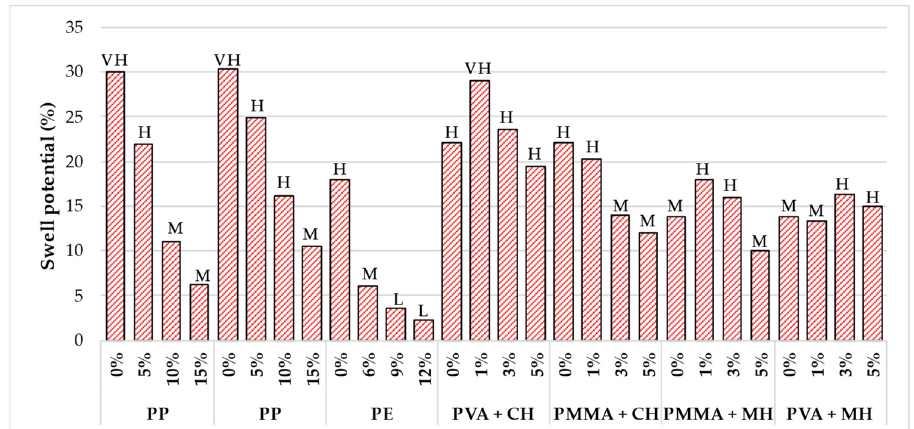
Figure 11. Influence on polymer treatment on the swell potential of expansive clay (concentration of PP, PVA and PMMA are defined as the % of the dry weight of soil). Note: this figure was created with data obtained from [110,143,171,177]. Table 3. Classification procedures for expansive soils. Adapted with permission Sridharan and Pra- kash (2000) [138] © ICE Publishing (2000).